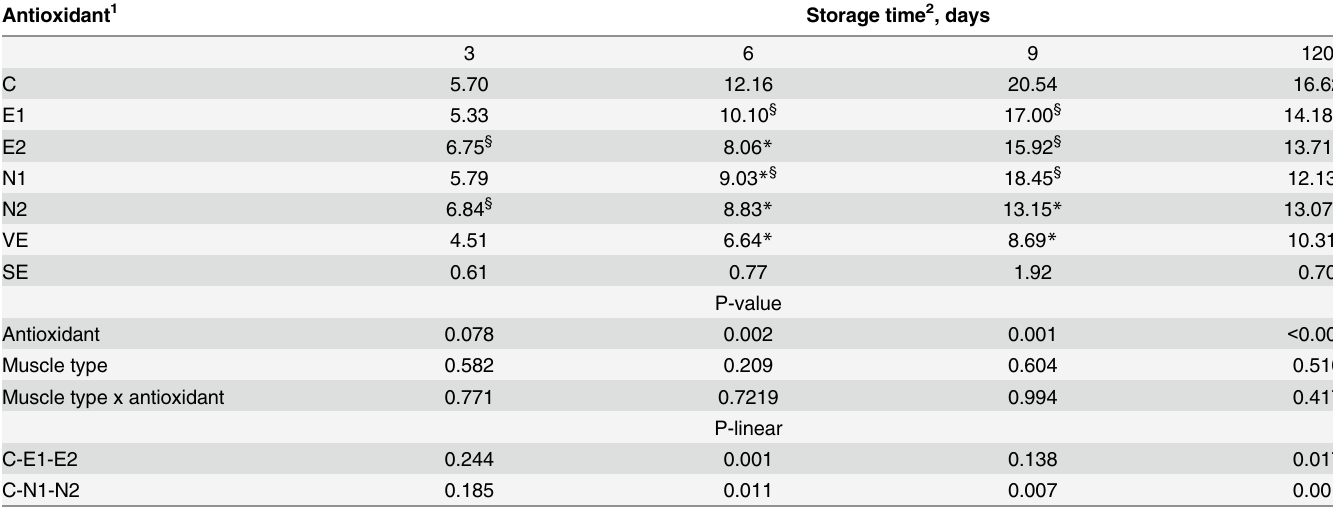
Table 4. Effect of dietary supplementation with naringin or hesperidin on broilers ’ meat (pectoralis major and biceps femoris) oxidative stability during storage (ng MDA/g meat) (n = 6). Antioxidant